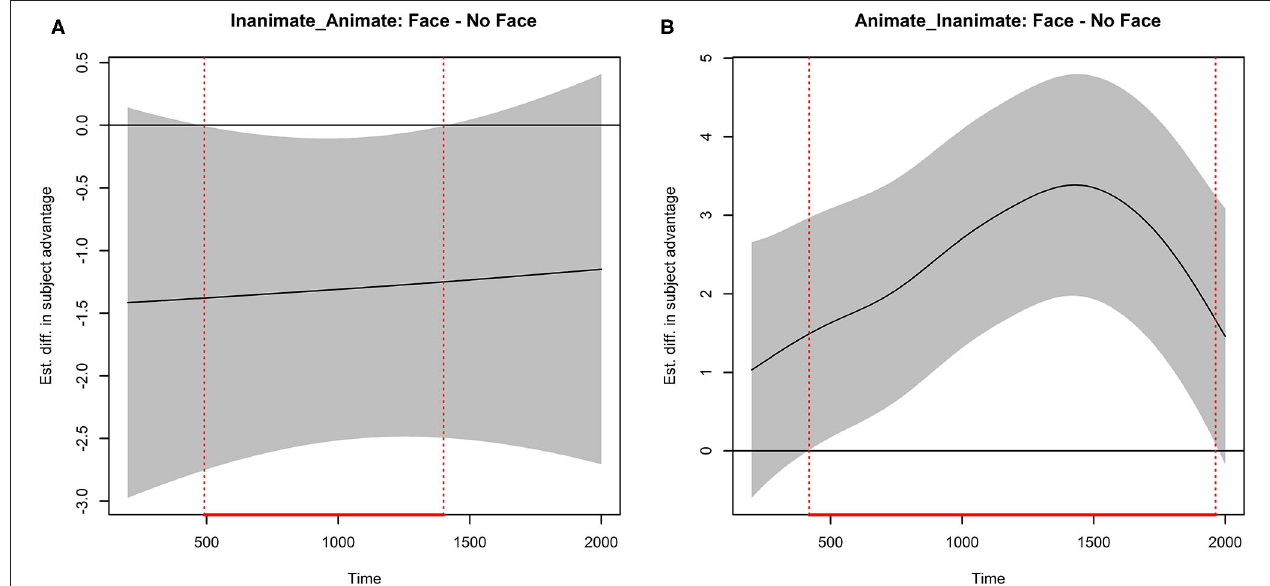
FIGURE 5 | Child data image condition difference curves calculated from model-predicted curves with 99% confidence bands. Vertical lines indicate time points for which zero is not included in the confidence bands. (A) Inanimate-animate Face minus NoFace conditions. (B) Animate-inanimate Face minus NoFace conditions.